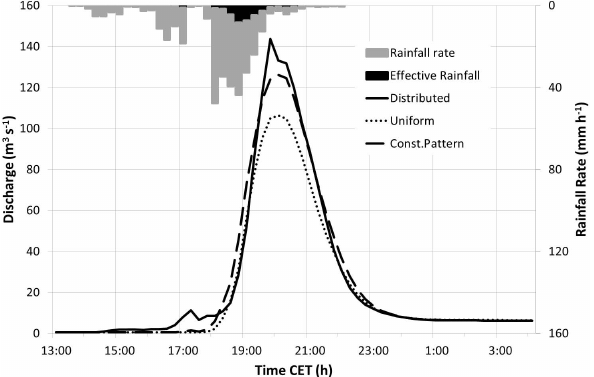
Fig. 15. Hydrograph analysis at the Rangendingen stream gauge station: resulting model-based hydrographs by using control rain- fall (Distributed), spatially uniform rainfall (Uniform) and constant spatial pattern (Const.